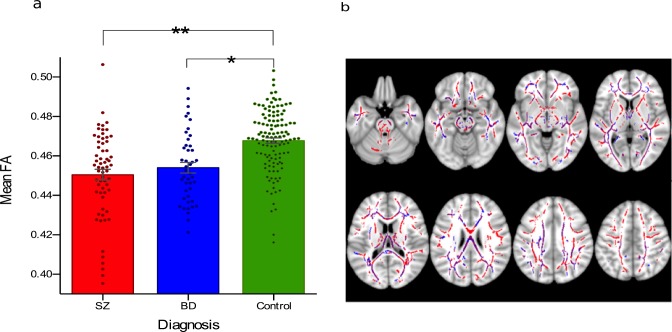
Main effect of diagnosis on fractional anisotropy.(A) FA was significantly reduced in SZ compared to controls (marked **) and in BD compared to controls (marked *), p < 0.05, TFCE corrected. Post-hoc analyses in the largest significant clusters revealed a respective Cohen’s d of 0.91 and 1.19, both considered ‘large’. The difference in FA between SZ and BD was not statistically significant. Individual data points show mean FA value for each participant within the largest cluster of the effect. b. Areas in which FA was significantly lower in SZ compared to controls are shown in red and areas where FA was significantly lower in BD compared to controls are shown in blue. Each effect encompassed one spatially extensive cluster. The overlapping areas where both effects are significant are shown in purple.